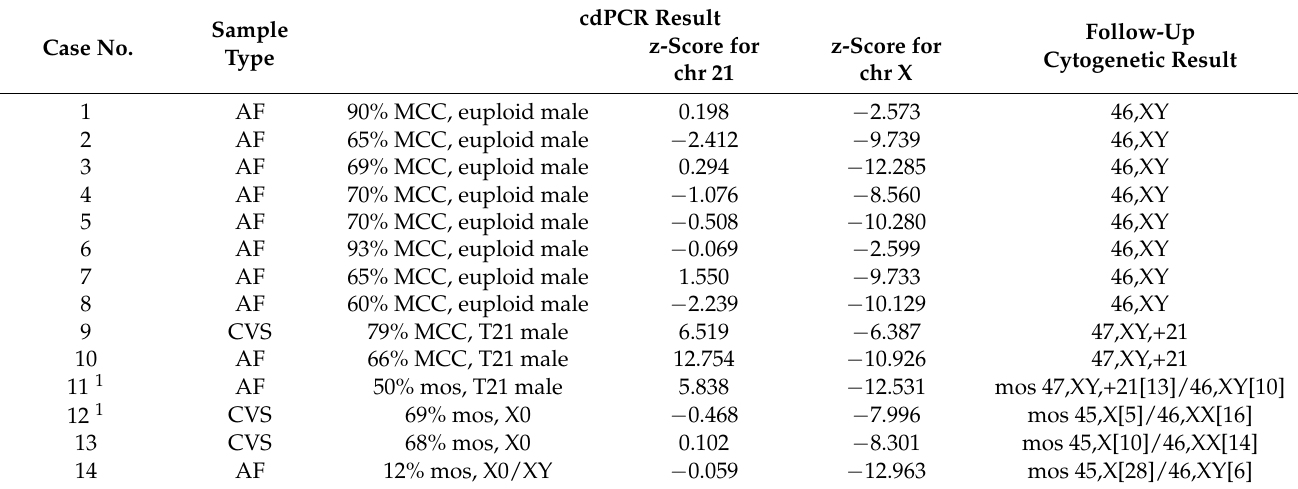
Table 1. Detection of MCC in clinical